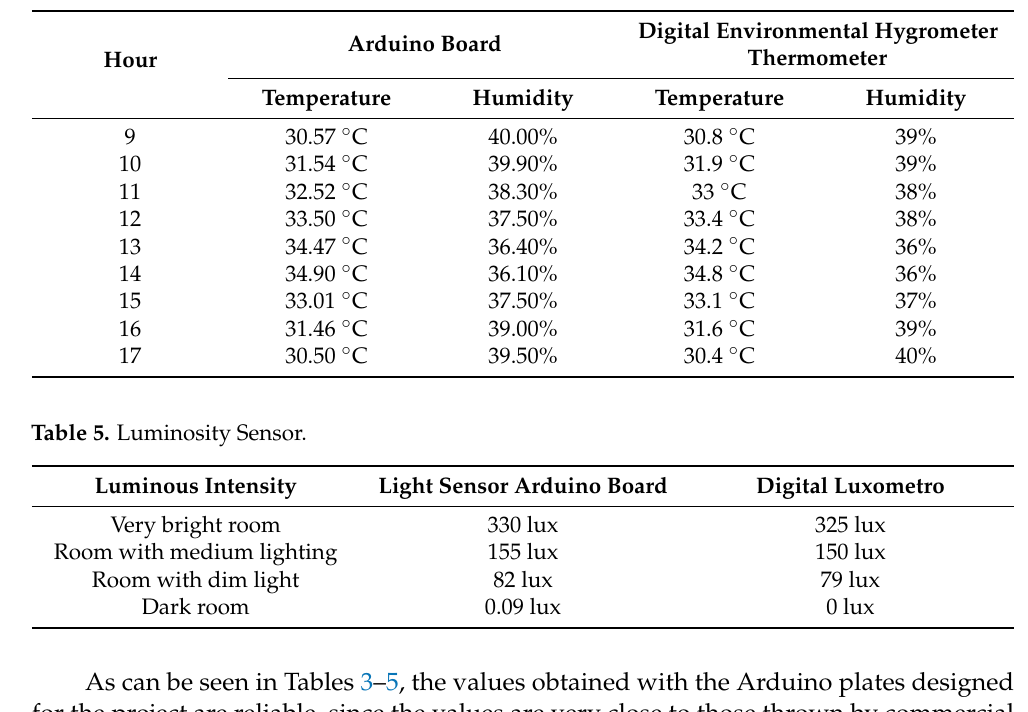
Table 4. Temperature and humidity sensor.